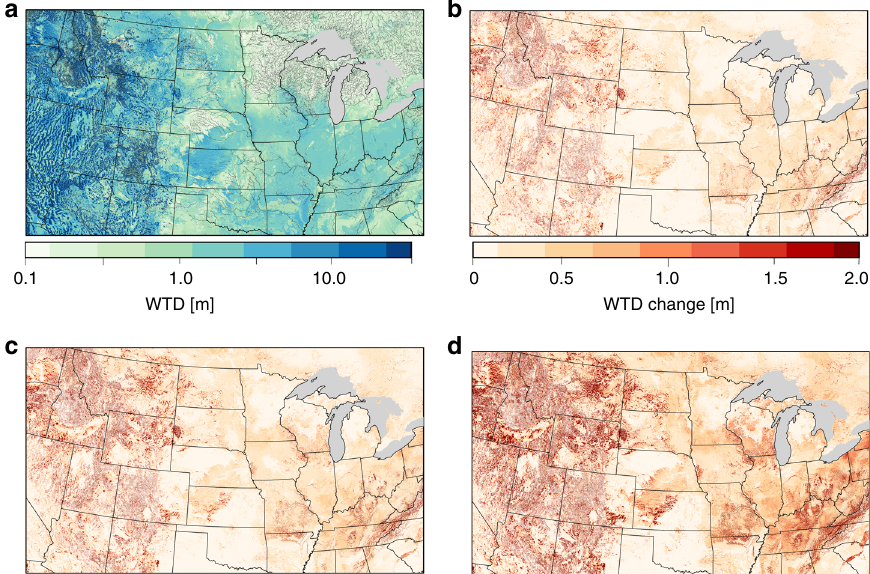
Fig. 2 Warming increases water table depth. a Map of the monthly average Water Table Depth (WTD) for the last month of the Baseline simulation compared to the difference the fi nal WTD (warming – Baseline) for each of the warming scenarios; 1.5 °C ( b ), 2 °C ( c ), and 4 °C ( d ).